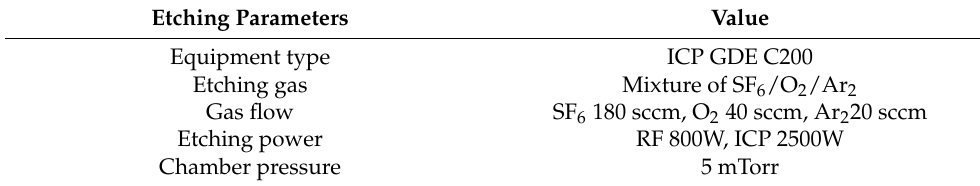
Table 2. ICP etching parameters of